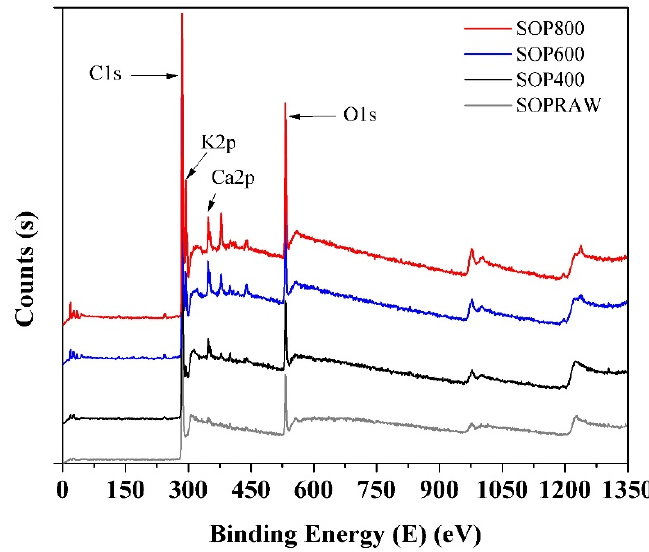
Figure 8. XPS survey spectra of SOPRAW and biochars.